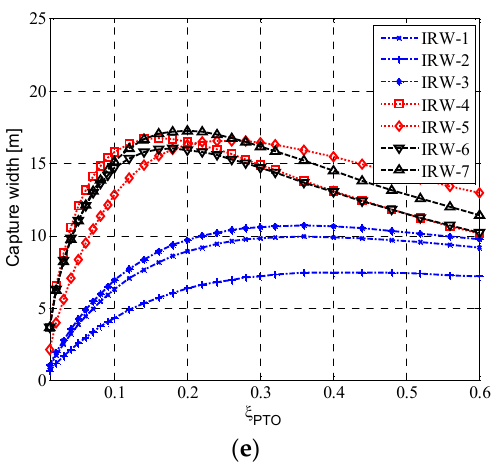
Figure 15. ( a ) The surge motion reduction ratio with the PTO damping ratio under different wave conditions with T PTO “ 9 s ; ( b ) the surge motion reduction ratio with the PTO damping ratio under different wave conditions with T PTO “ 9 s ; ( c ) the pitch motion reduction ratio with the PTO damping ratio under different wave conditions with T PTO “ 9 s ; ( d ) the maximum relative displacement of Plate 1 with the PTO damping ratio under different wave conditions with T PTO “ 9 s ; ( e ) the capture width with the PTO damping ratio under different wave conditions with T PTO “ 9 s .